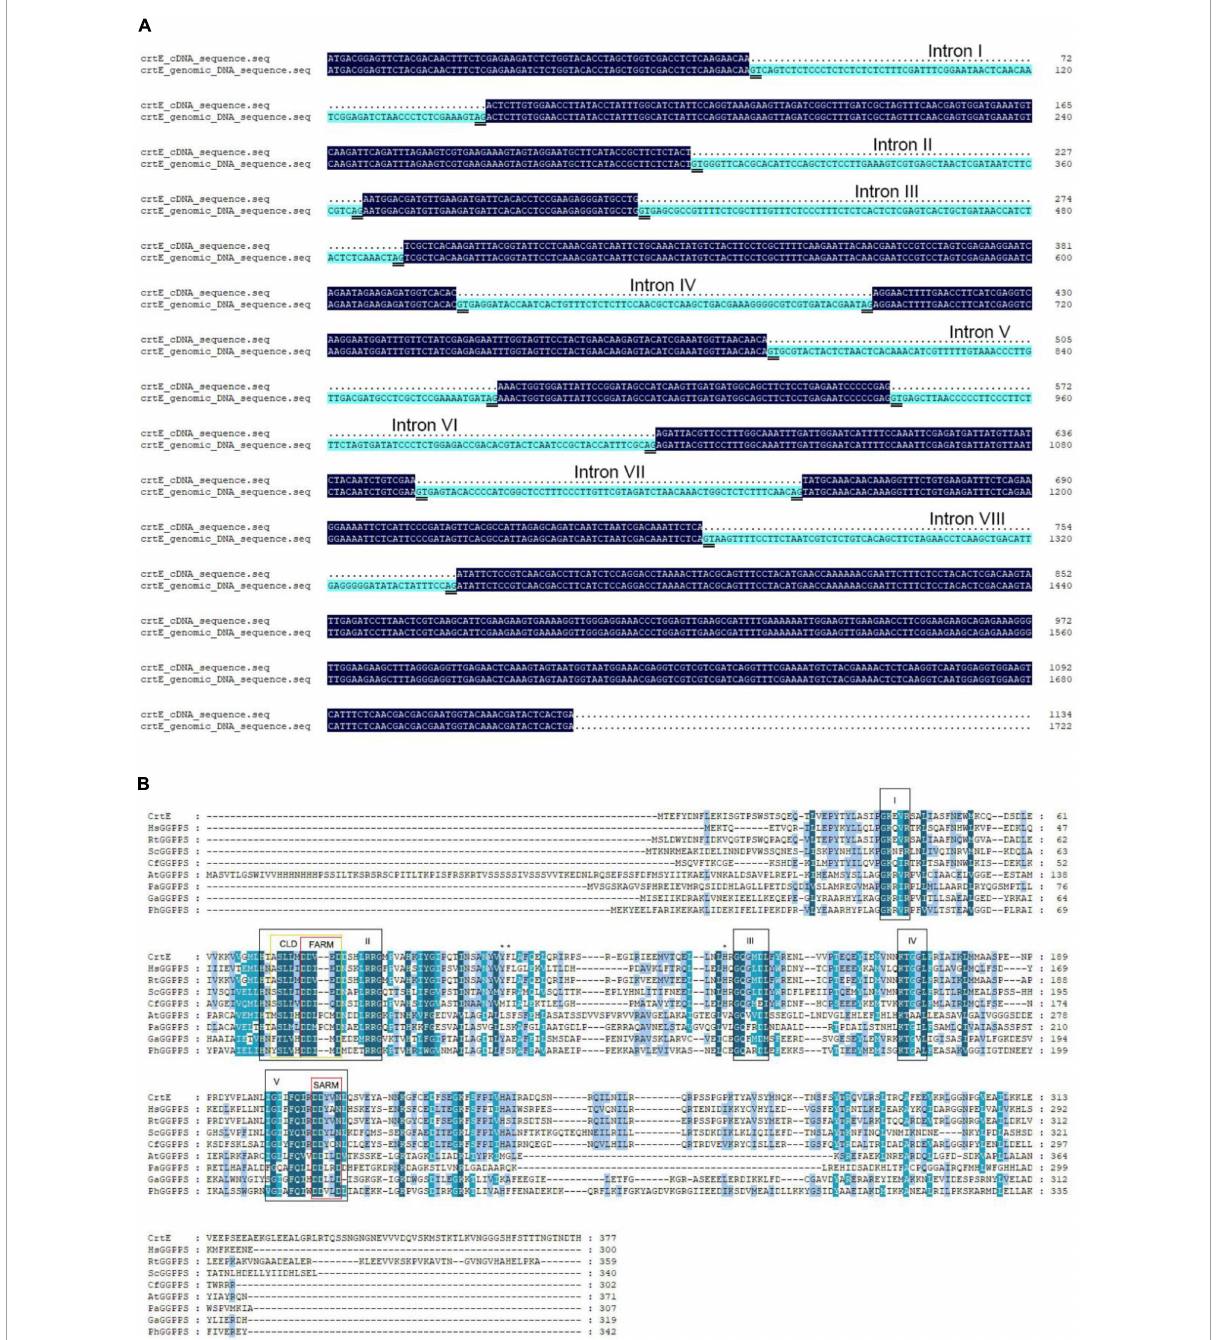
FIGURE2 Sequences alignment. (A) Alignment of the crtE cDNA sequence with genomic DNA sequence of S. pararoseus NGR. (B) Alignment were made between geranylgeranyl diphosphate synthetase amino acid sequences in different species. Abbreviations and accession numbers: CrtE, Sporobolomyces pararoseus GGPPS, AVN68390.1; HsGGPPS, Human GGPPS, BAA75909.1; RtGGPPS, Rhodotorula toruloides GGPPS, BBE10611.1; ScGGPPS, Saccharomyces cerevisiae GGPPS, 2E8T_A; CfGGPPS, Choristoneura fumiferana GGPPS, AGW99945.1; AtGGPPS, Arabidopsis thaliana GGPPS, AAA32797.1; PaGGPPS, Pantoea agglomerans pyrophosphate synthase, AAA64977.1; GaGGPPS, Geoglobus acetivorans GGPPS, WP_048092150.1; PhGGPPS, Pyrococcus horikoshii GGPPS, WP_010885159.1. Conserved sequence motifs found in GGPPS are labeled as I–V and highlighted with black boxes. Domains II and V contain first aspartic acid-rich motif (FARM) and second aspartic acid-rich motif (SARM), respectively, both highlighted by red boxes. The region which contains the FARM and the five amino acids upstream is the chain length determination region (CLD), highlighted by a yellow box. The three bulky amino acids Tyr110, Phe111, and His141) mentioned in the main text are marked with an asterisk